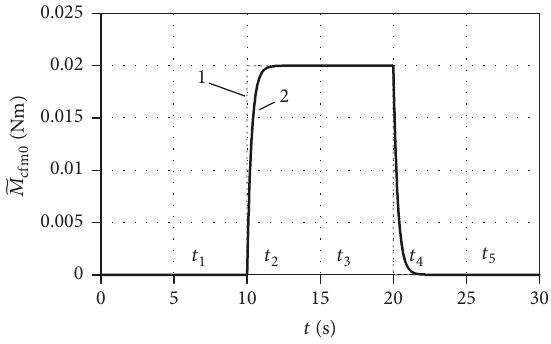
Figure 6: Estimation of constant fault system.